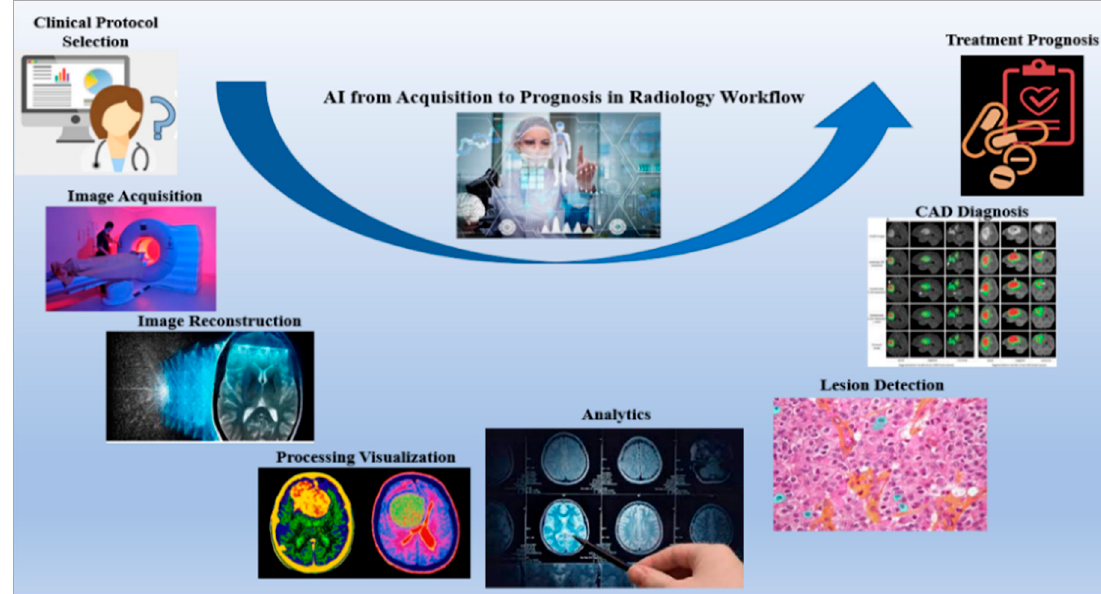
Figure 8. Role of AI in improving the pipeline of radiology, from clinical protocol selection to treatment prognosis [12].